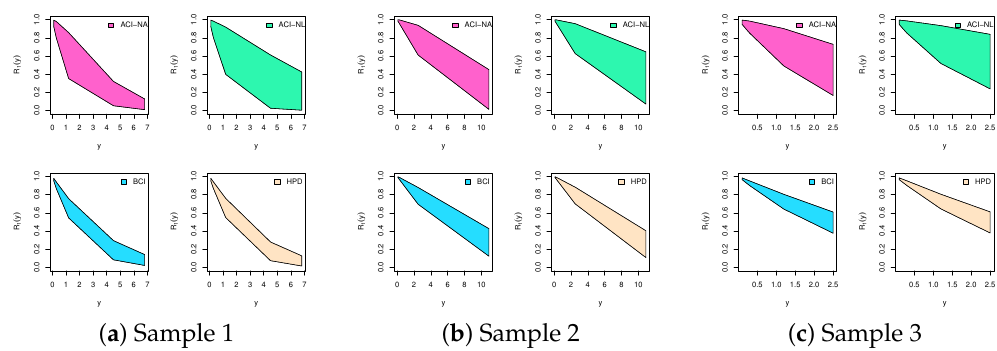
Figure 8. Point estimates of R 1 ( y ) from insulating fluid data.